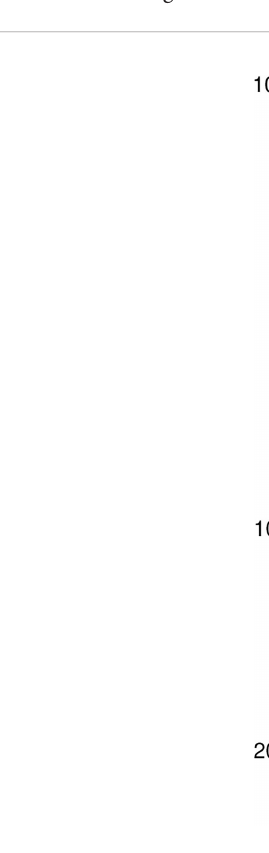
FIGURE 1 | Observation stations along 80°E (I08N) that were used in this study. We used three sections that were occupied in March (316N14_7 by R/V Knorr; Swift and Becker, 2019a), September 1995 (3175MB95_07 by R/V_Malcolm Baldrige; Swift and Becker, 2019b), and December 2019. The stations in March 1995 and December 2019 are shifted to 1° west and east,